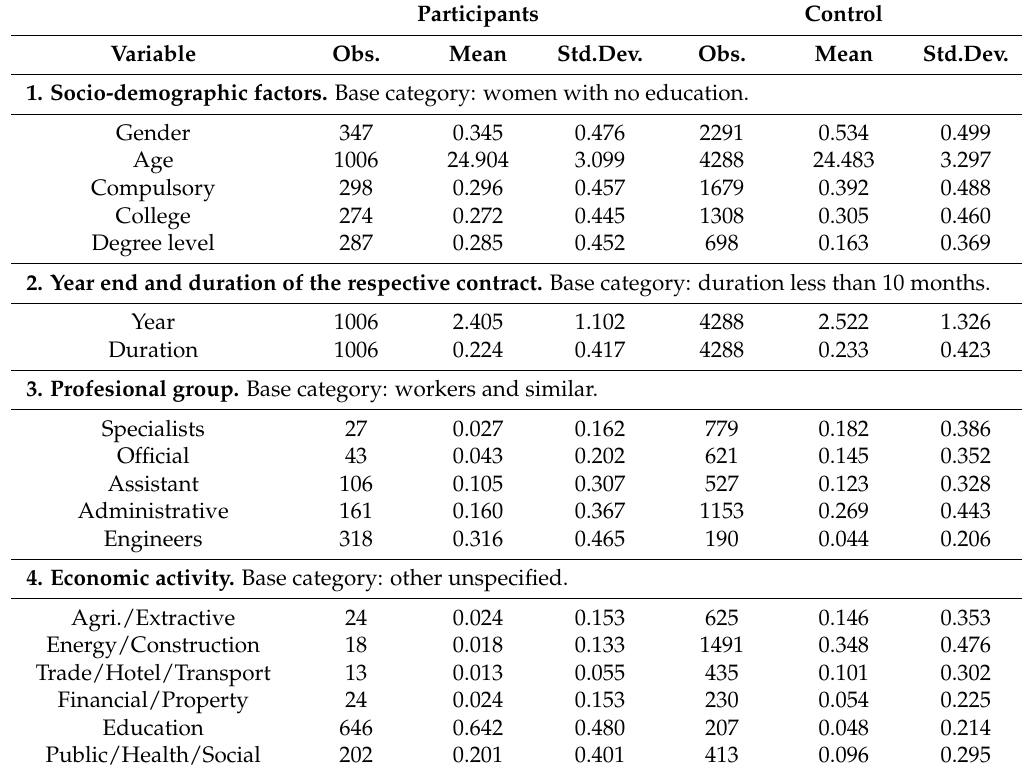
Table 2. Covariates and descriptive statistics: Treatment and control